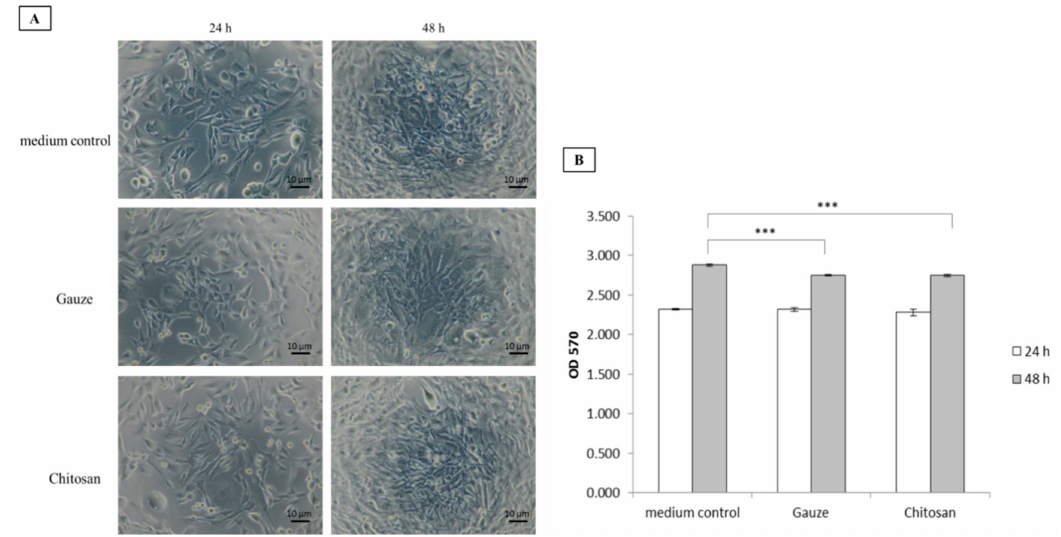
Figure 5. Biocompatibility of gauze and chitosan fiber dressings. ( A ) Cell morphology. ( B ) Cell viability, *** p < 0.001. (WS1 fibroblasts; 24 h and 48 h